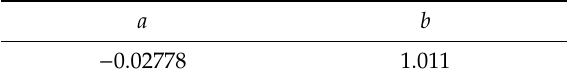
Figure 3. The linear fitting between the SOH and the mean | degree of polarization (DOP) | (25 ◦ C, 1 C cyclic charging and discharging until the available capacity reaches 80%) With 95% confidence bounds (–0.03097, –0.02459) and (0.9988, 1.024), the constant coe ffi cients a and b are settled, as shown in Table 3. Table 3. The identification of constant coefficients a and b .